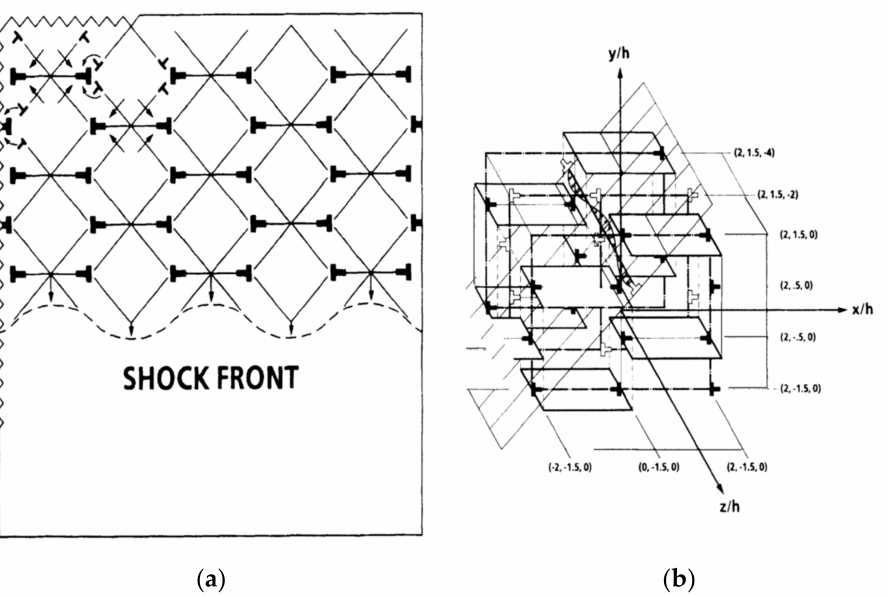
Figure 3. ( a ) Two-dimensional shock model for achievement of a one-dimensional state of com- pressive strain for a propagating shock wave [12]; ( b ) extension to a three-dimensional prismatic dislocation structure through which slip on an inclined plane would be restricted from cutting through the shocked nanostructure